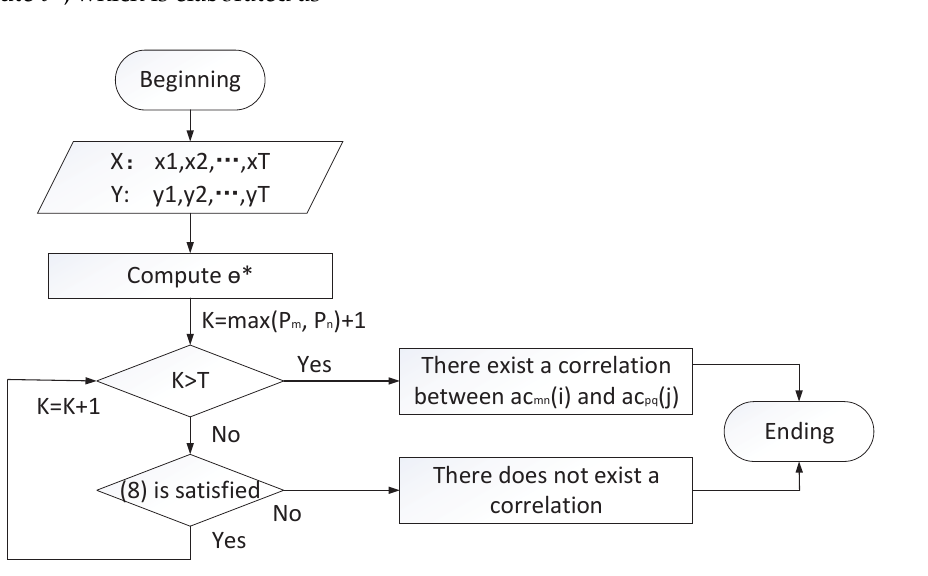
Figure 7. The flowchart of correlation mining between two